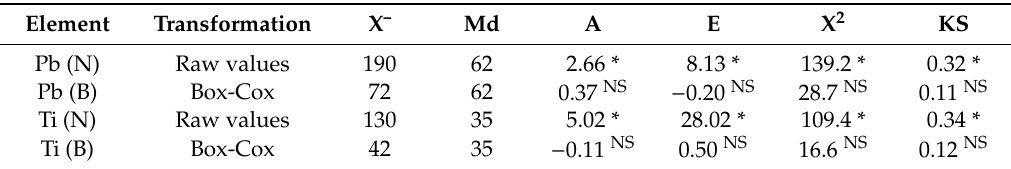
Table 1. Comparison between the statistical parameters of raw data ( n = 111) and predicted values ( n =